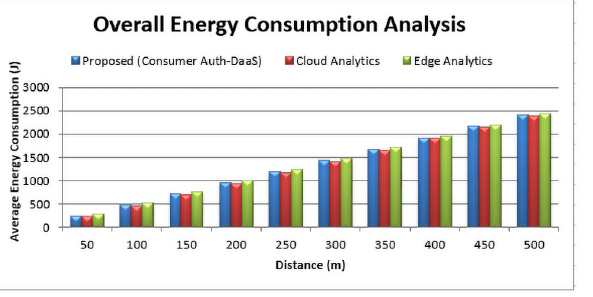
Fig 6. Energy utilization comparison among cloud computing, edge computing and the proposed hybrid computing based Consumer-Auth framework.